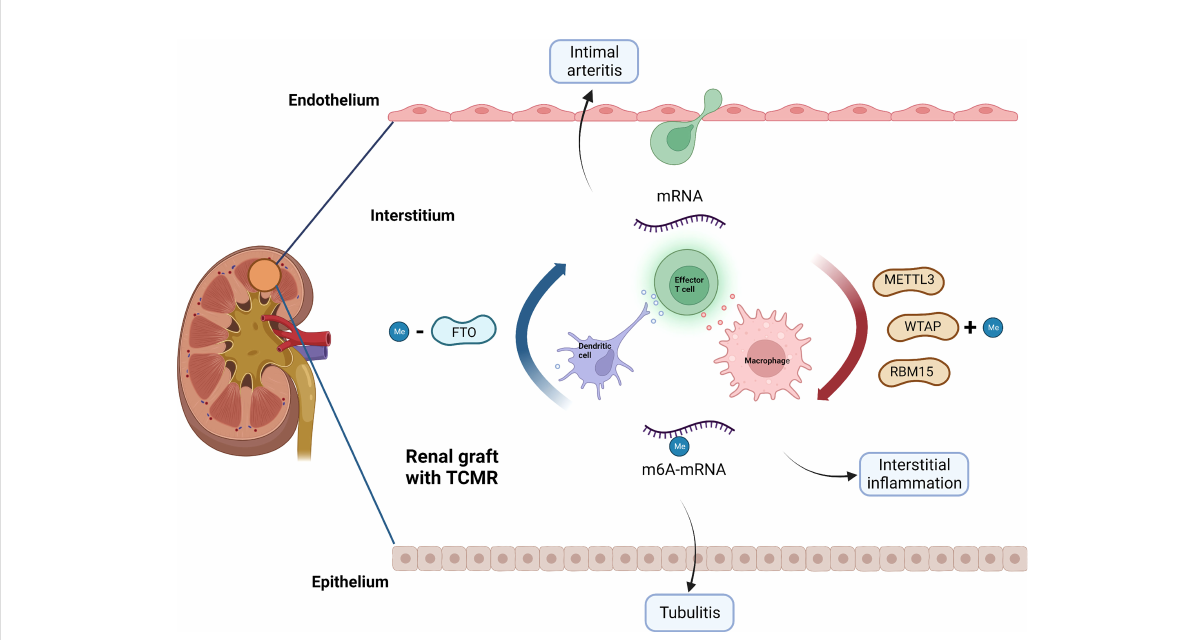
FIGURE 8 Potential role of m6A modi fi cation in TCMR. METTL3, WTAP, RBM15 and FTO may be involved in the pathogenesis of TCMR by regulating immune response, thereby causing interstitial in fl ammation, tubulitis and intimal arteritis. TCMR, T cell mediated rejection; Me,